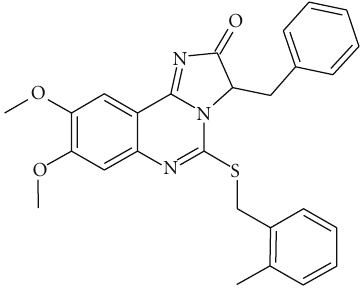
Figure 4: Structure of hMRGPRD antagonist, MU-6840.